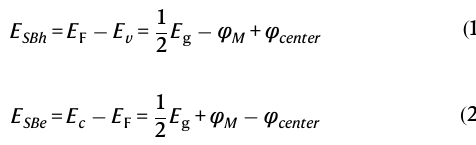
Fig. 2 | Electrical characterization of transistors constructed from various single-chirality SWCNT fi lms. a Schematic diagram of a typical top-gate TFT. b – f Transfer curves of various single-chirality SWCNT TFTs, which were classi fi ed by their family(red forTypeII SWCNTsand blue forTypeI SWCNTs). Blackarrows